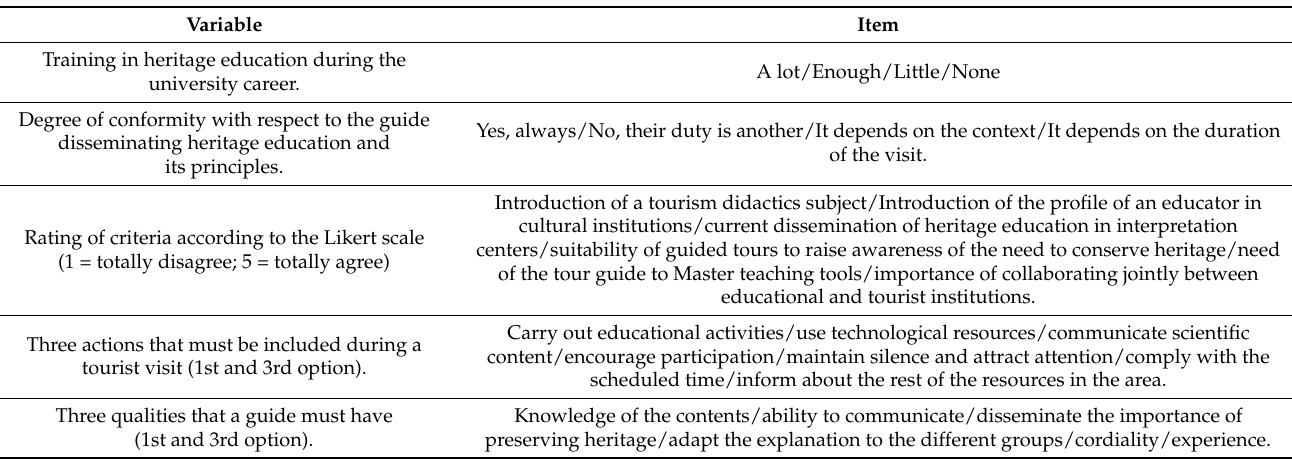
Table 5. Analysis variables in the survey of students or graduates in Primary Education or Tourism.